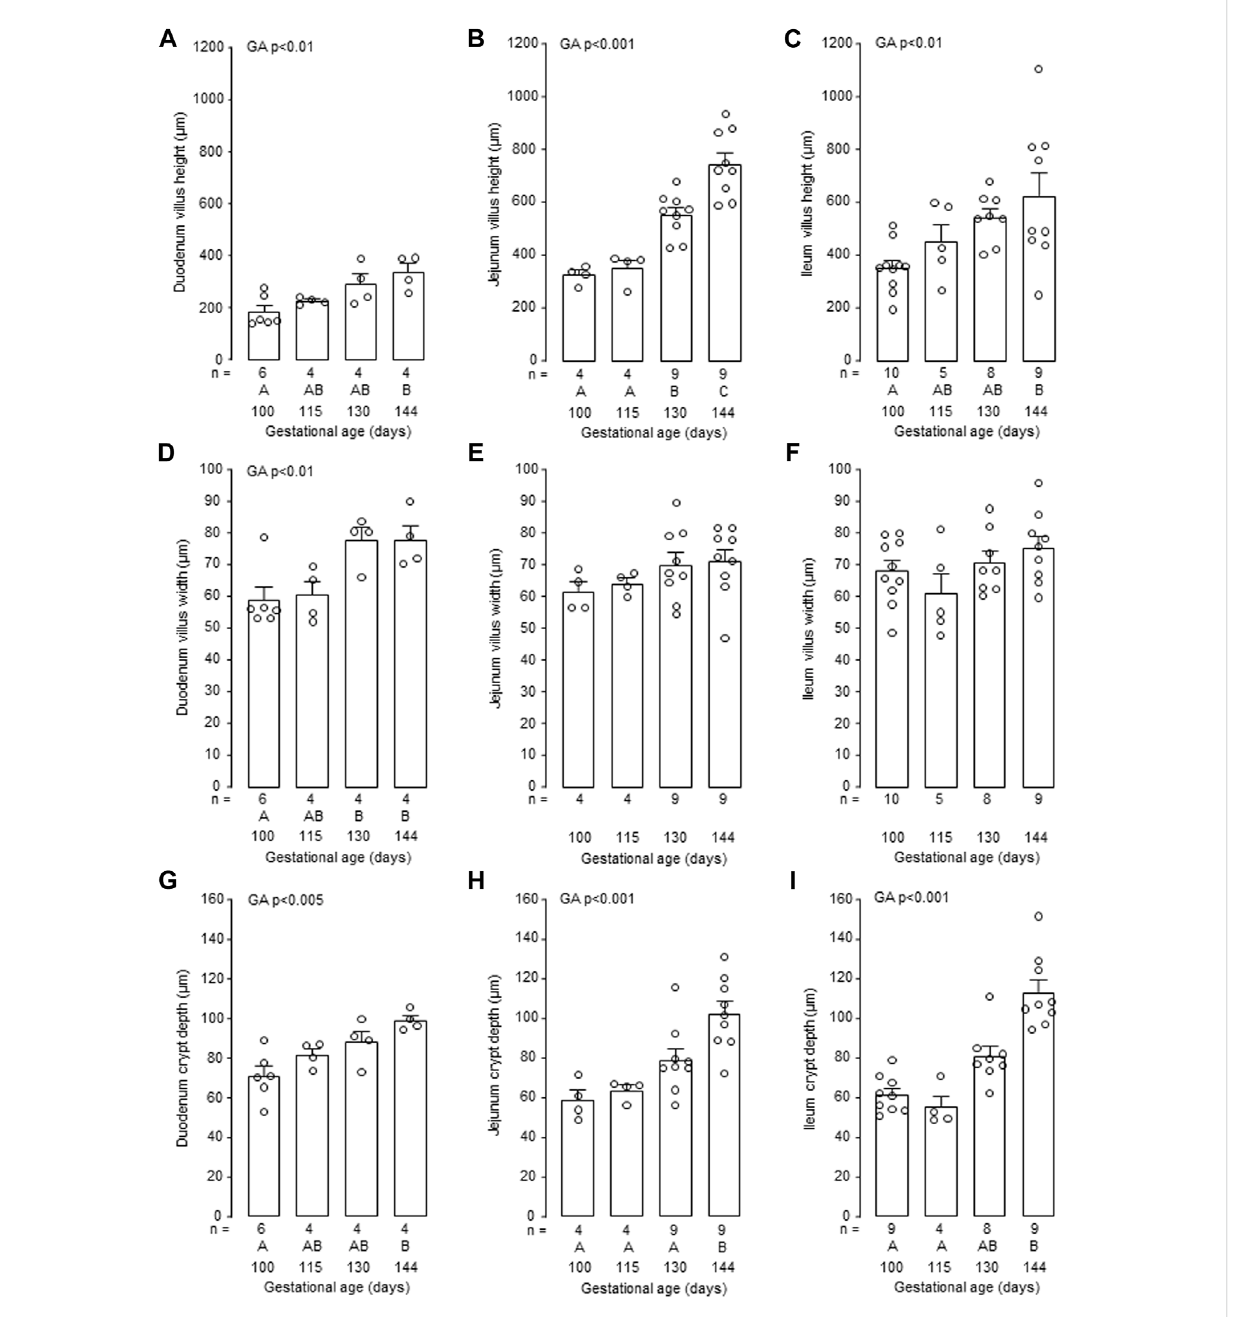
FIGURE 6 Mean (±SEM) and individual measurements of villus height (A – C) , villus width (D – F) and crypt depth (G – I) in the duodenum, jejunum and ileum of theintactfetusesstudiedbetween100and144 daysofgestation. Foreachparameter measured,valueswithdifferentlettersatthebaseofthehistogram are signi fi cantly different from each other ( p < 0.05, one-way ANOVA). Numbers of fetuses in each group are indicated at the base of the histogram. GA, gestational age; TX,